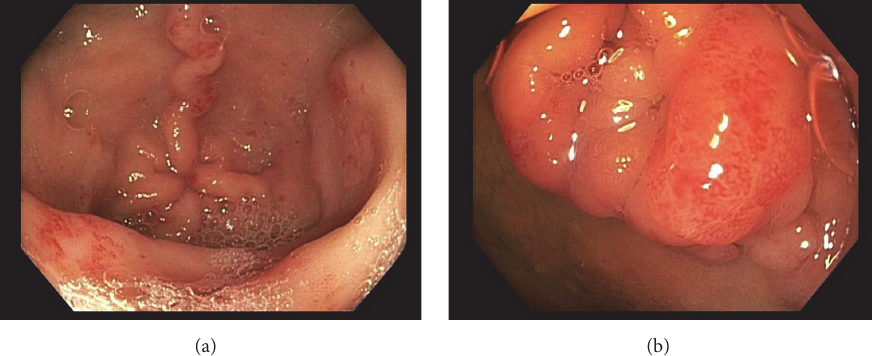
Figure 1: Initial esophagogastroduodenoscopy (EGD) demonstrating gastric antral vascular ectasias (GAVE) without evidence of active oozing (a) and frond-like mass in the duodenal bulb with no active bleeding or stigmata of recent bleed (b).